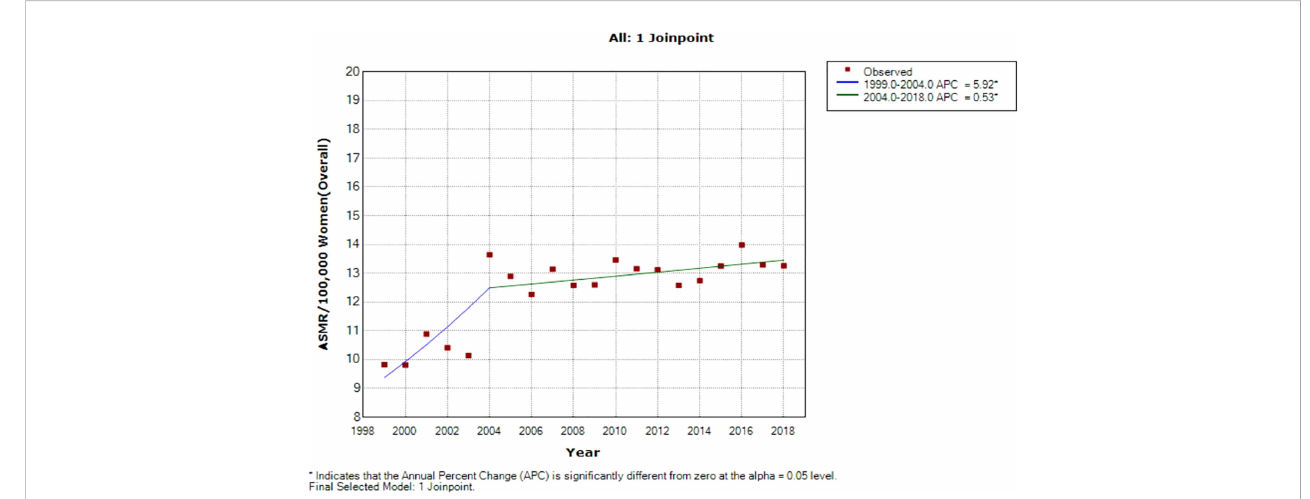
TABLE 2 Joinpoint regression estimates of the trends in National and Ethnic age-standardized mortality rates of breast cancers in South Africa (1999 – 2018). Cancer type Trends Year period APC 95% CI P-value Comment Breast Overall ASMR